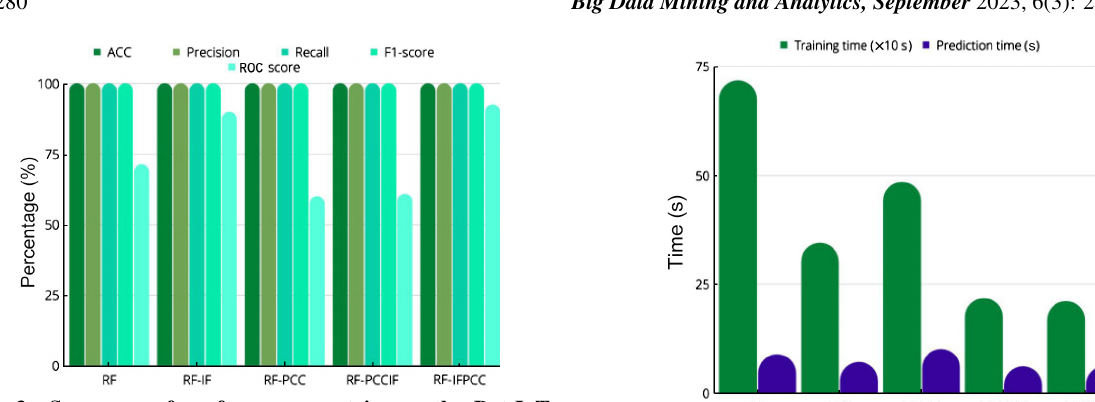
Fig. 3 Summary of performance metrics on the Bot-IoT dataset. Fig. 4 Training time and prediction time consumed by our models on Bot-IoT.